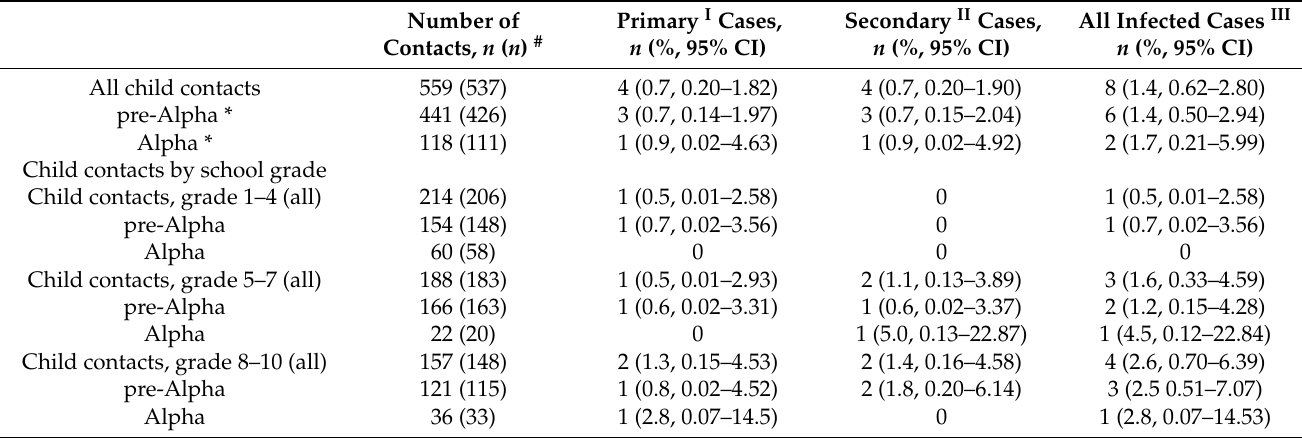
Table 2. Primary, secondary and all infected child contacts detected in school contact investigations (n, 43) within 7–10 days following the last exposure, Oslo and Viken, August 2020–May 2021.